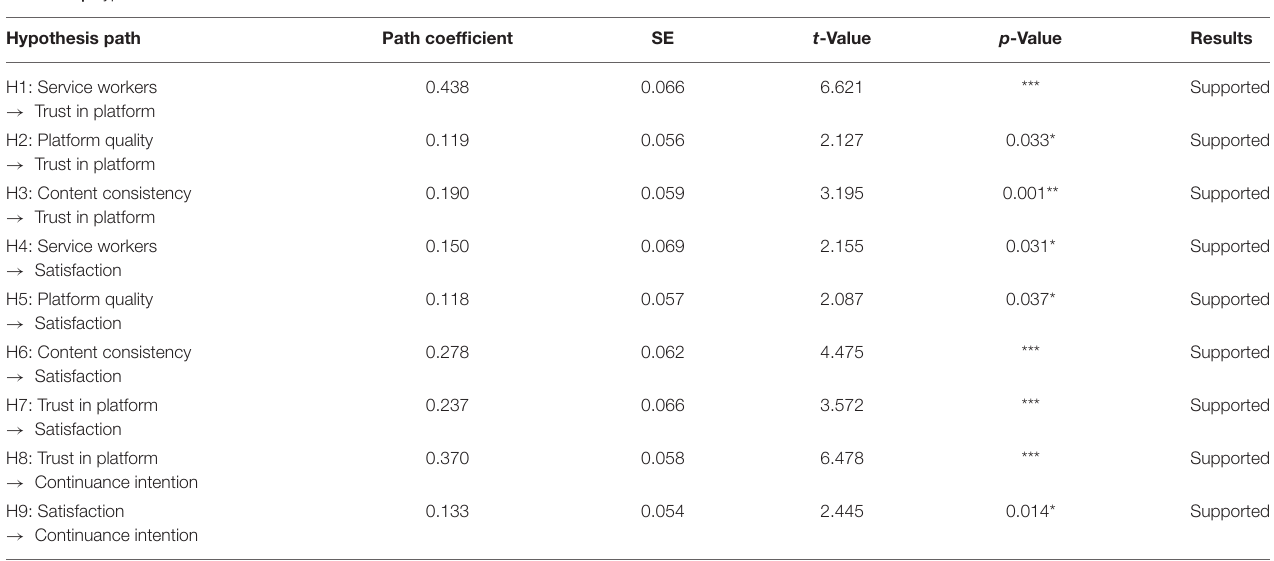
TABLE 5 | Hypotheses